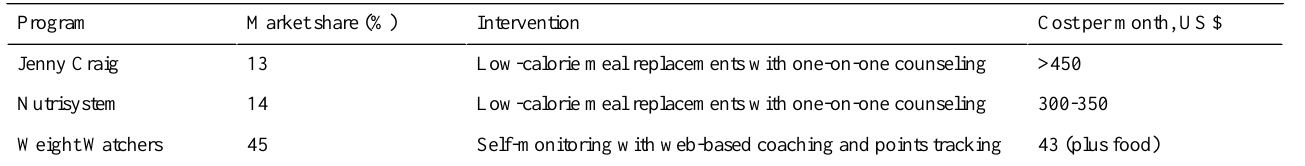
Table 1. Commercial weight loss